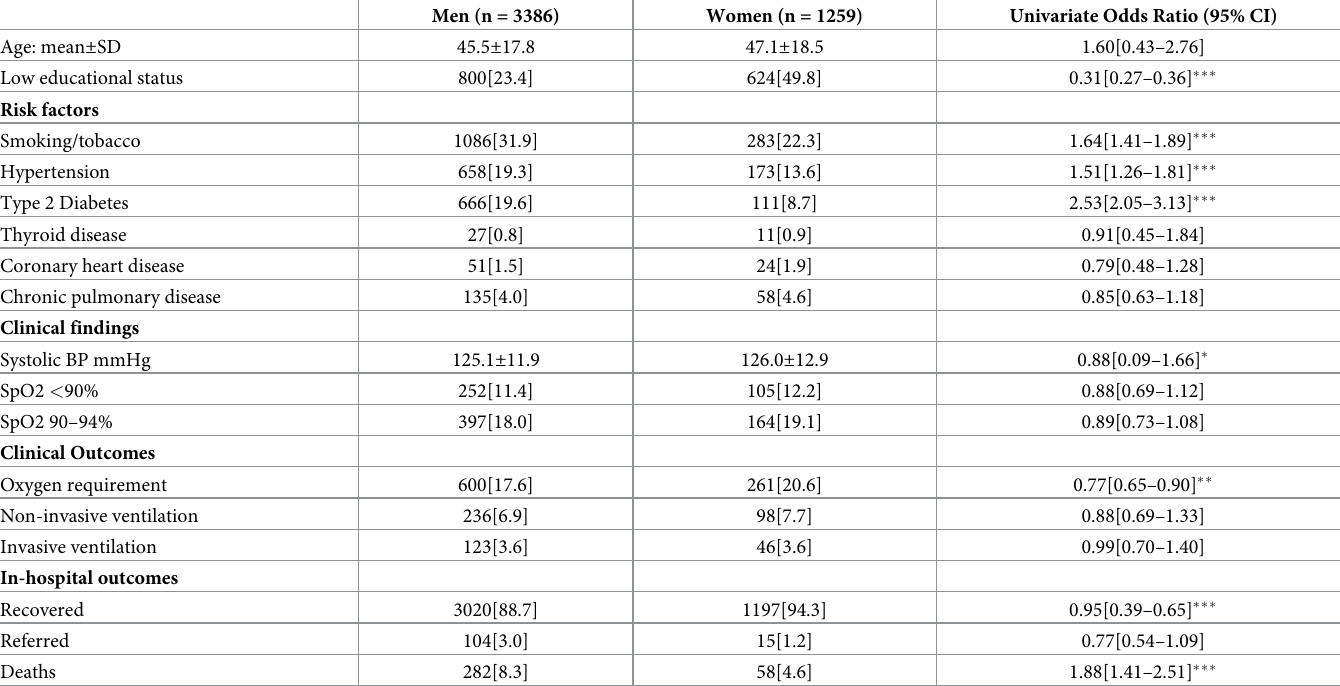
Table 2. Clinical characteristics and outcomes according and to